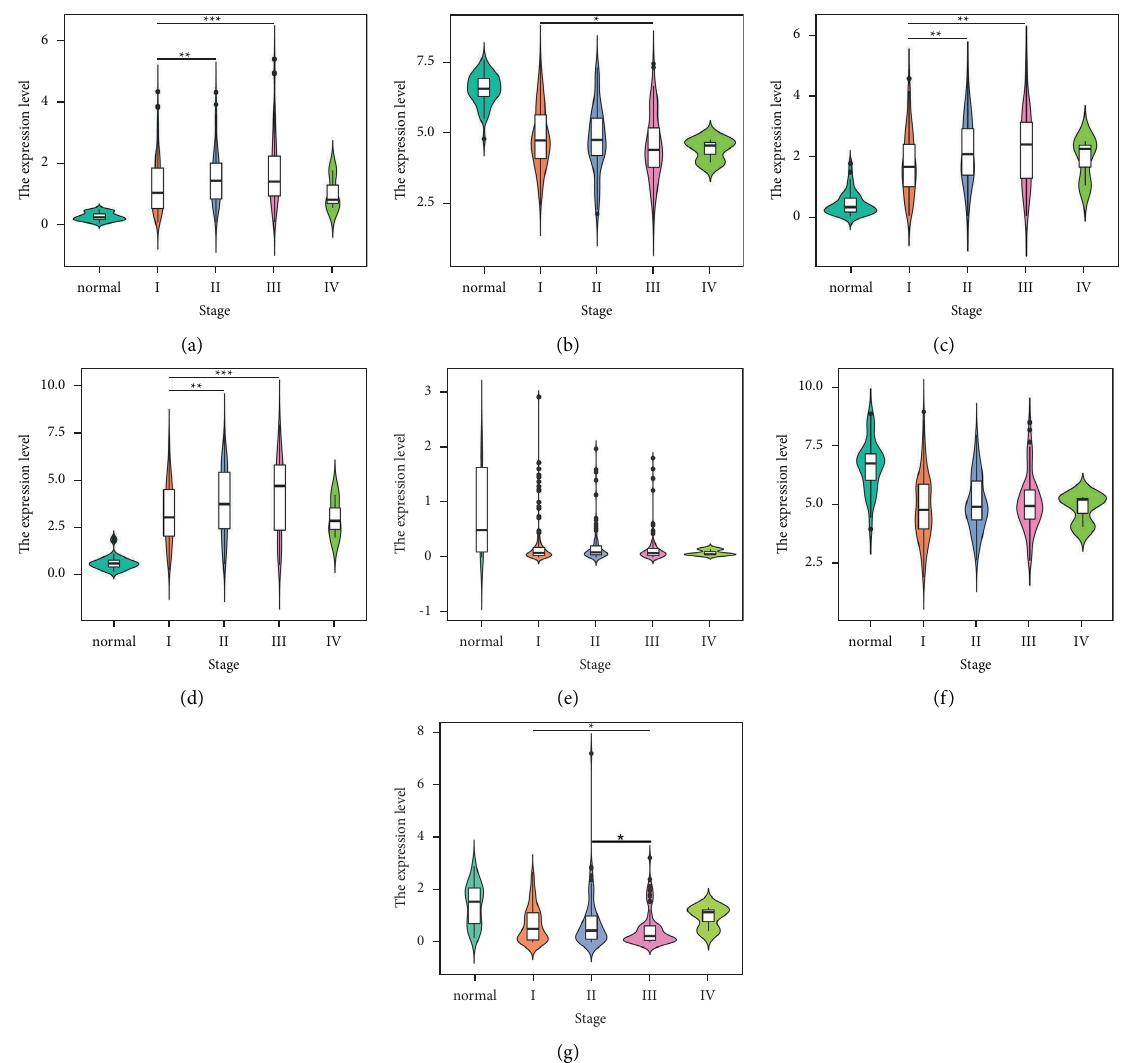
Figure 6: Expression of important DEGs in HCC patients with diferent stages: (a) MAFG-DT; (b) GSTZ1; (c) GPRIN1; (d) MYBL2; (e) LINC00907; (f) CCN1; (g) GSTM5 ( ∗ P < 0 . 05, ∗∗ P < 0 . 01, ∗∗∗ P < 0 .